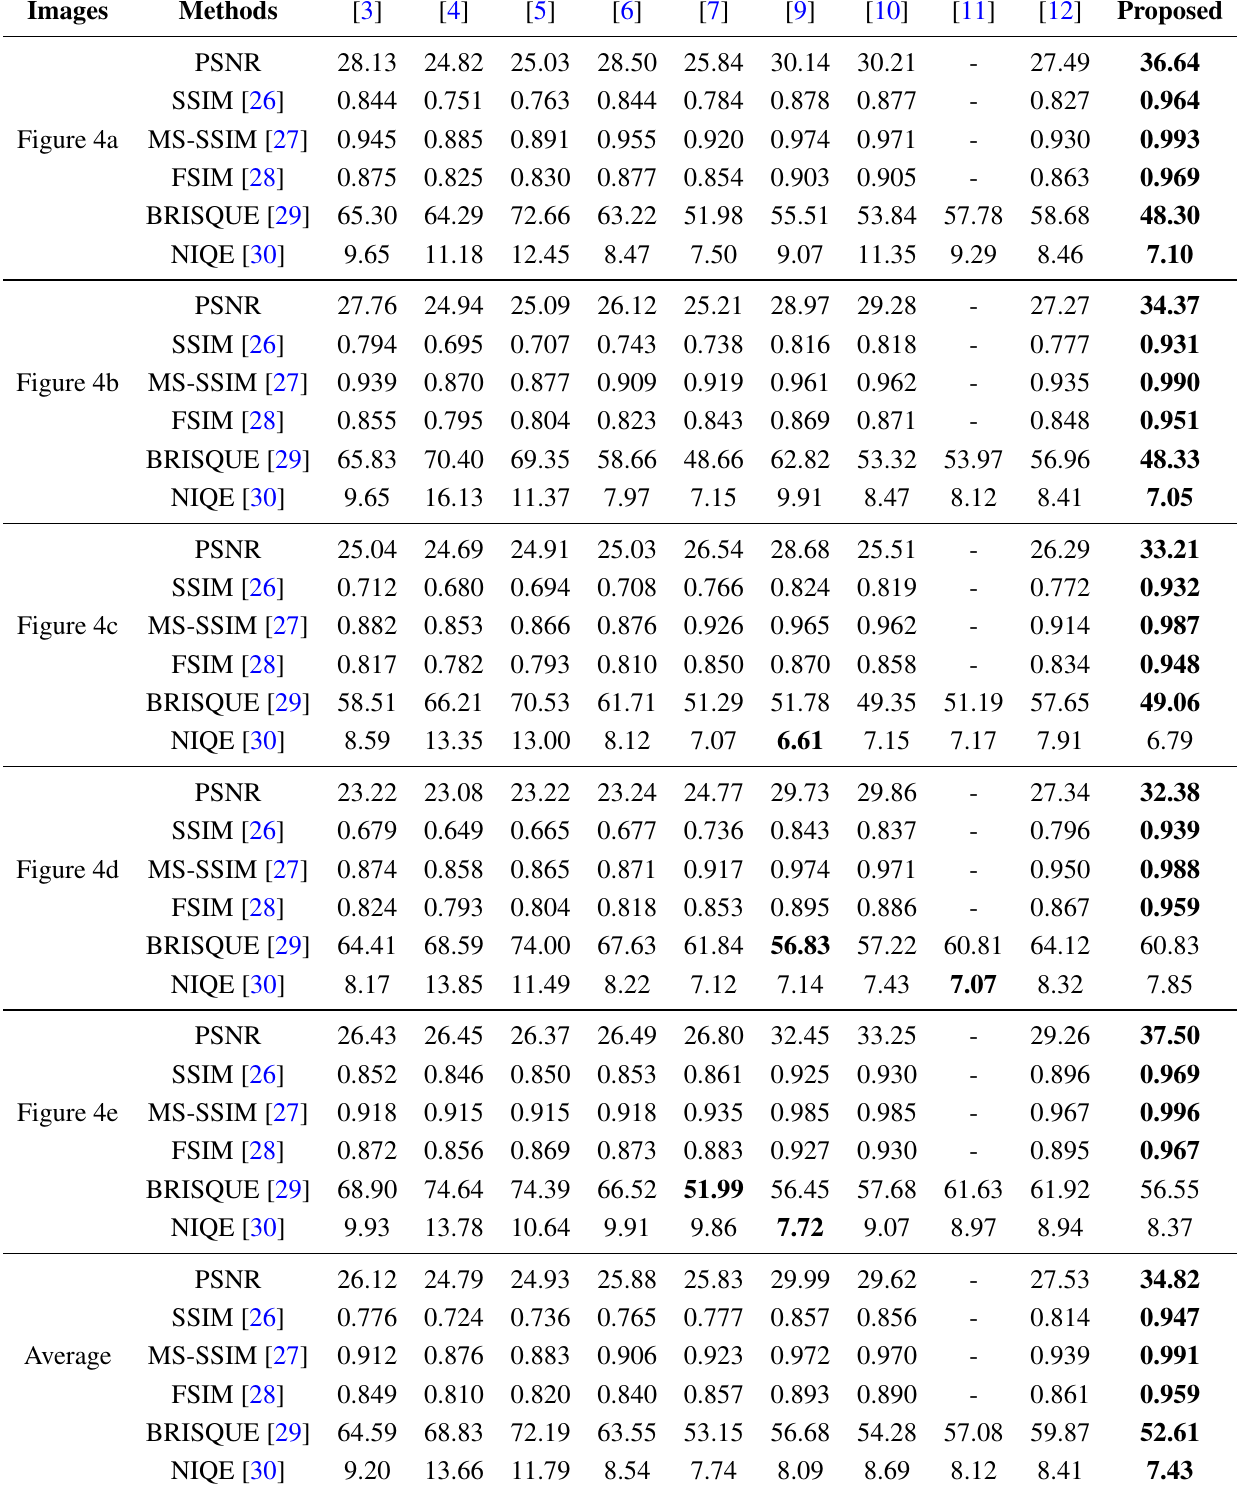
Table 1. Comparison of peak-to-peak signal-to-noise ratio (PSNR), structural similarity index measure (SSIM), multiscale-SSIM (MS-SSIM), feature similarity index (FSIM), blind/referenceless image spatial quality evaluator (BRISQUE) and natural image quality evaluator (NIQE) values of the resulting images shown in Figure 4 using nine existing